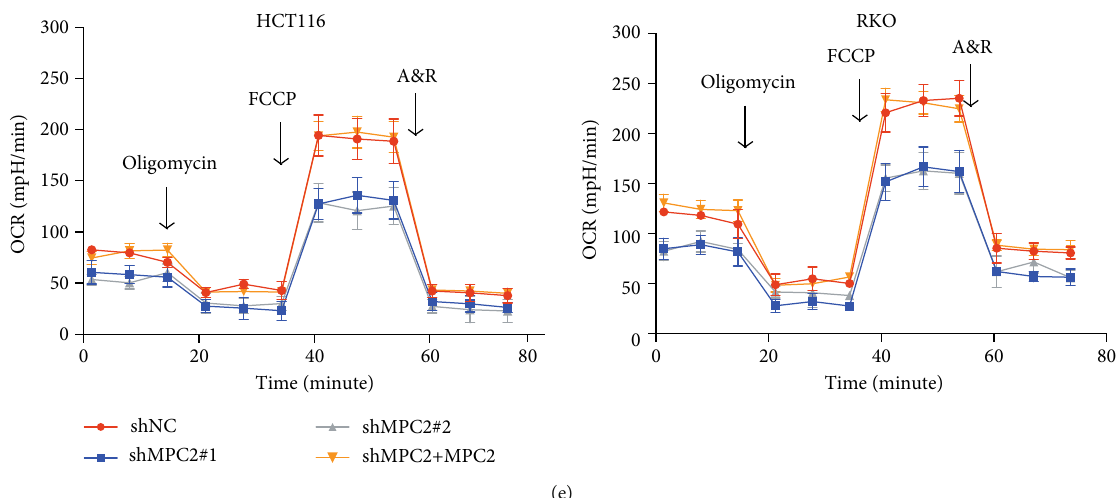
Figure 3: MPC2 expression suppressed glycolysis in CRC cells. (a) GSEA of MPC2 expression in CRC samples from the TCGA database. (b) Lactate production and glucose intake of CRC cells transfected with shNC or shMPC2 (relative to shNC). (c) Relative mRNA levels of glycolysis-related genes of HCT116 (left) as well as RKO cells (right) transfected with shNC or shMPC2 (relative to shNC). (d) Glycolytic function of HCT116 as well as RKO cells under the indicated treatments as measured by extracellular acidi fi cation rate (ECAR). 2-DG: 2- deoxyglucose (oxidative phosphorylation inhibitor). (e) Mitochondrial stress test of RKO cells (right) and HCT116 cells (left) and in MPC2 knockdown and/or overexpression under the indicated treatments as measured by oxygen consumption rate (OCR). A&R: actinomycin A (mitochondrial complex III inhibitor) and rotenone (the mitochondrial complex I inhibitor). ∗ p < 0 : 05 , ∗∗ p < 0 : 01 , ∗∗∗ p < 0 : 001 , and ∗∗∗∗ p < 0 : 0001